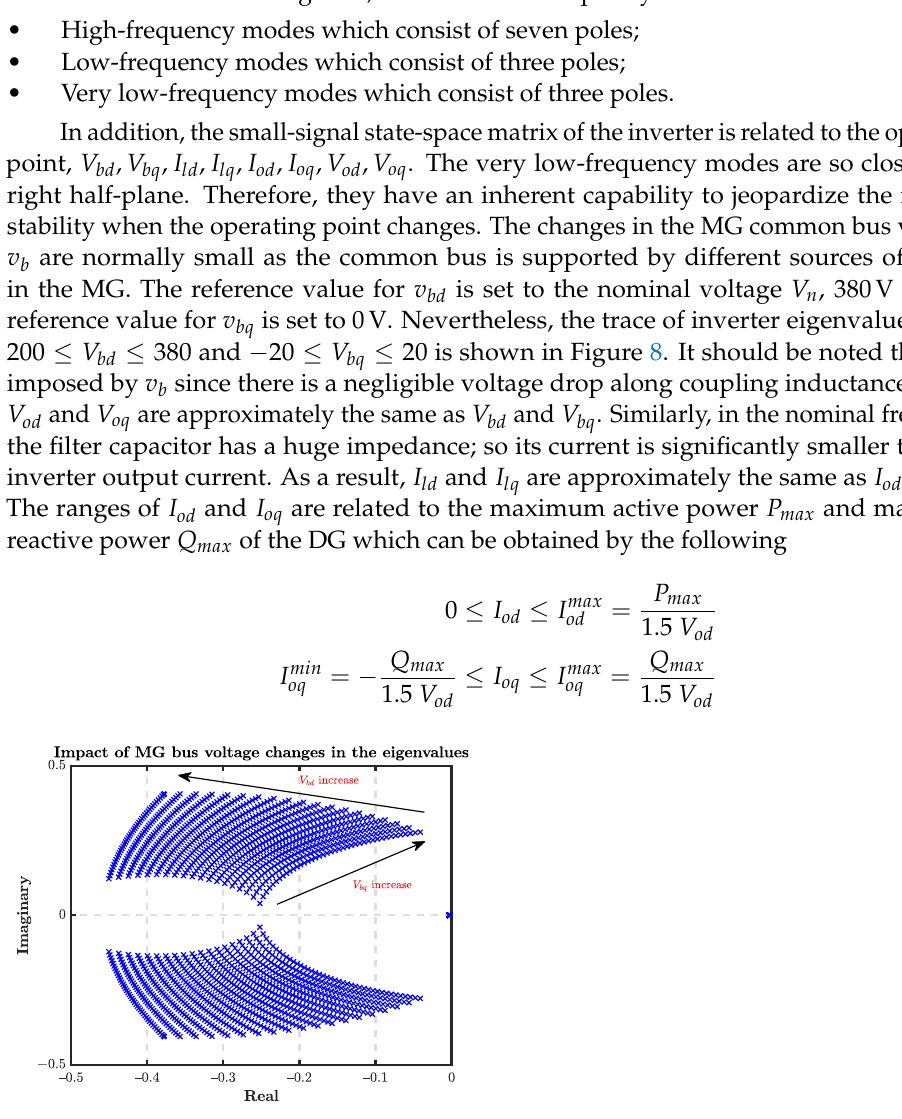
Figure 8. The trace of eigenvalues for 200 ≤ V bd ≤ 380 and − 20 ≤ V bq ≤